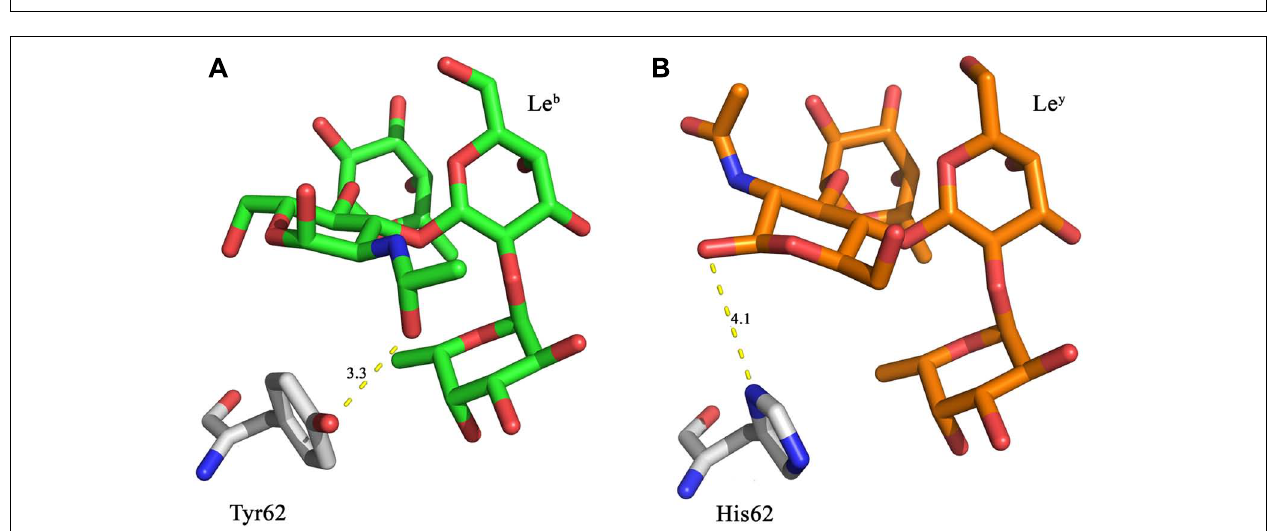
FIGURE 1 | Structural comparison of Le b and Le y antigens. Lewis antigens Le b (A) and Le y (B) are structurally very similar.They differ in the